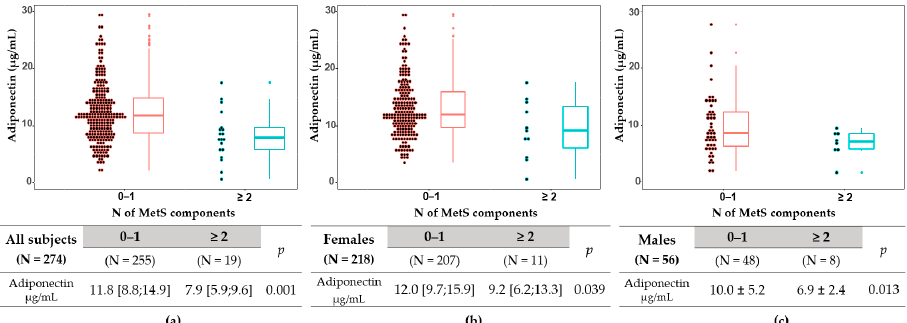
Figure 2. Box-and-whisker dot plots. Two group comparisons of serum adiponectin levels with or without multiple metabolic syndrome components ( ≥ 2) in all subjects ( a ), females ( b ), and males ( c ). An independent two-sample test ( t -test or Mann – Whitney test) was used after the normality test.